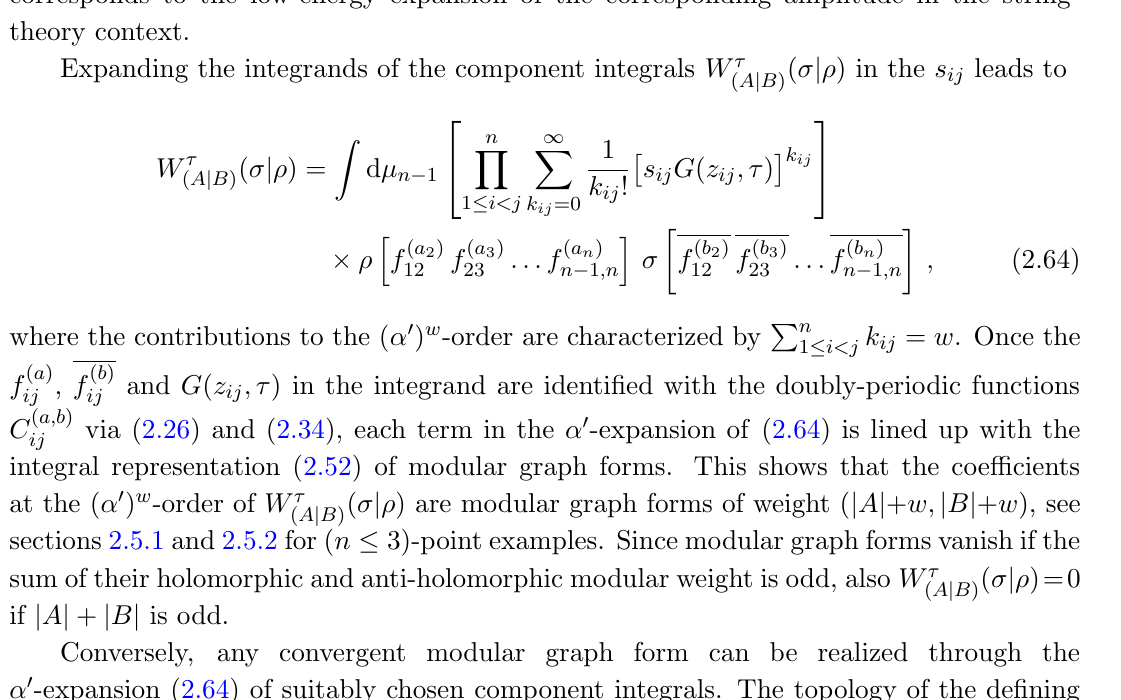
Figure 2 . The graph associated to the trihedral modular graph form C expansion of the W (cid:28)